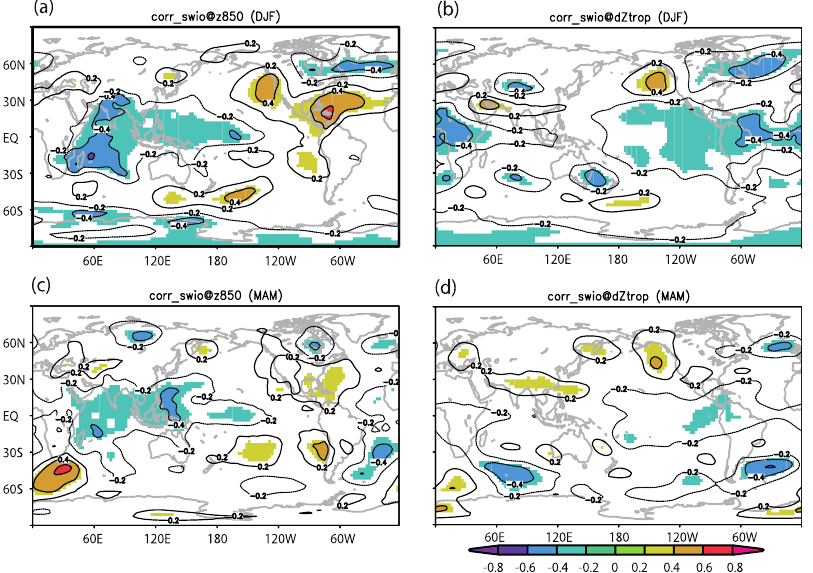
Figure 5. Same as Figure 2 but for z850 (left panels) and tropospheric thickness (z200-z850; right panels) anomalies. ( a ) DJF z850, ( b ) DJF z200-z850, ( c ) MAM z850, ( d ) MAM z200-z850.